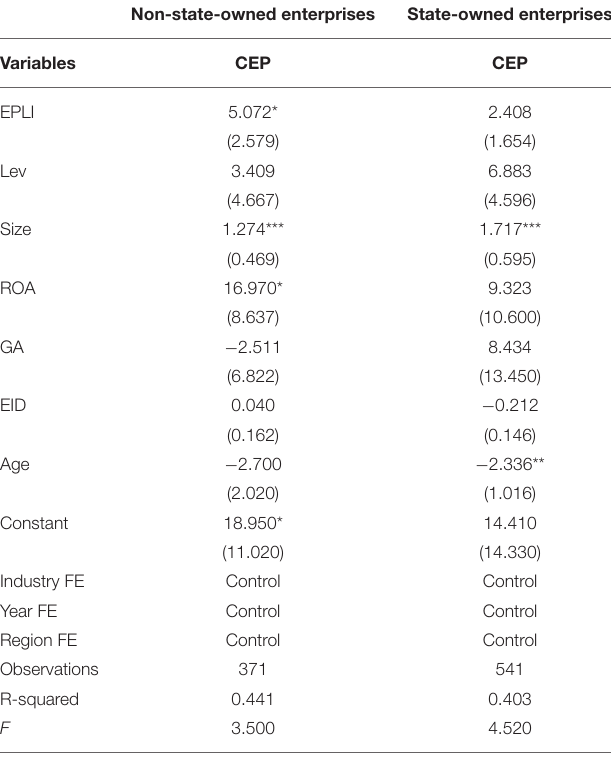
TABLE 5 | Model regression results